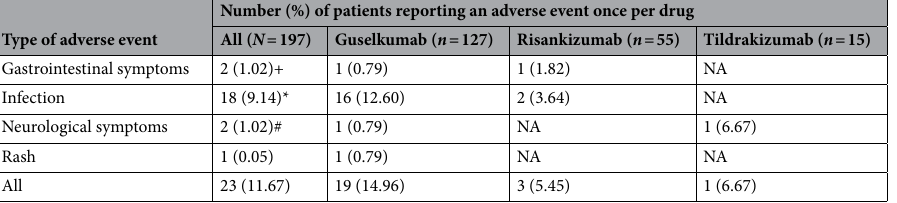
Table 6. Occurrence of adverse events under treatment with Il-23 inhibitors. Fisher’s exact test results indicate no significant differences in the occurrence of adverse events regarding drug ( p = 0.159). N = 197. NA, not applicable (none). +Included two patients with diarrhoea. *Included seven patients with common cold, two patients with coronavirus disease 2019 (COVID-19), two patients with cellulitis, one patient with influenza, one patient with herpes zoster, one patient with skin abscess, one patient with angina tonsillaris, one patient with tooth abscess, and two patients with unspecified infections. #Included one patient with headache and one patient with headache and